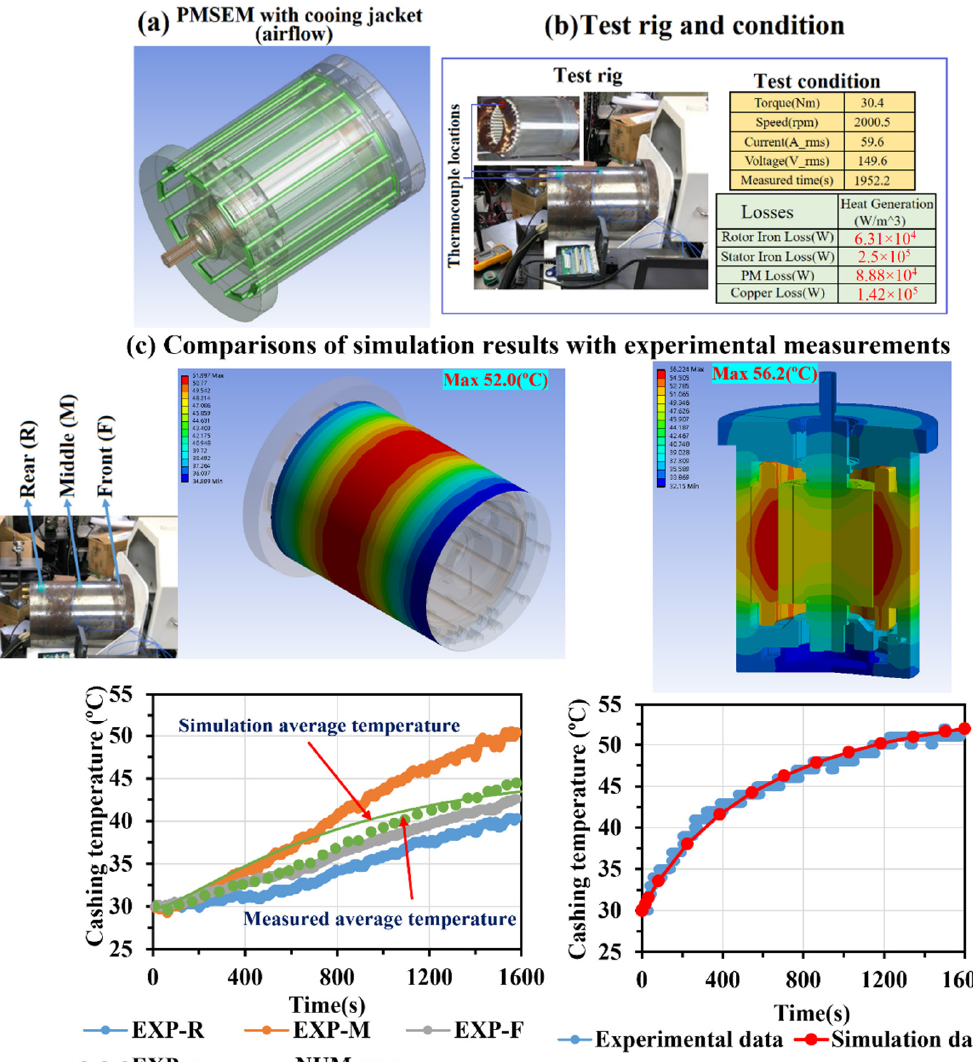
Figure 8. ( a ) configuration of electric motor simulated and tested ( b ) experimental rig and test condition for validation of simulation model ( c ) comparisons between simulation results and experi- mental measurements.